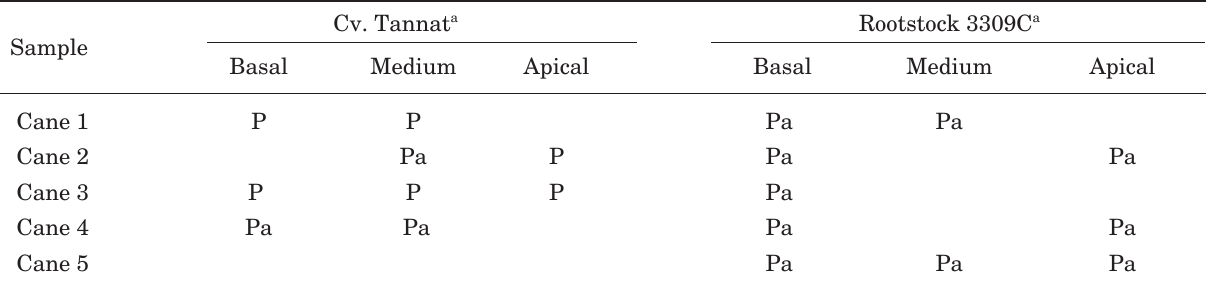
Table 3. PCR amplification of DNA from cuttings from different positions on different grapevine cultivars, using selected specific primers F2Bt/R1Bt for Phaeoacremonium spp . and Pmo1f/Pmo2r for Phaeomoniella